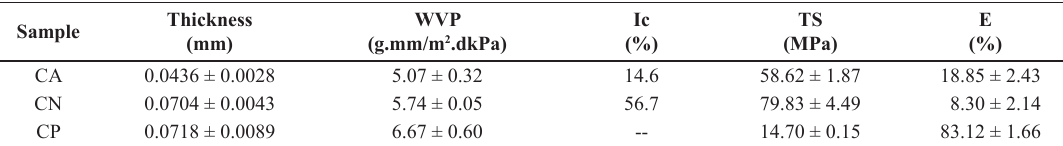
Table 1. Proprieties of chitosan membranes: thickness, water vapor permeability (WVP), crystallinity index (Ic), tensile strength (TS) and elongation at break (E). Sample